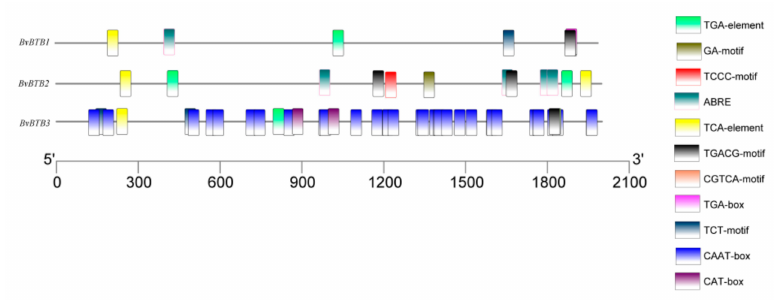
Figure 6. Analysis of promoter elements of BvBTB , BvBTB2 , and